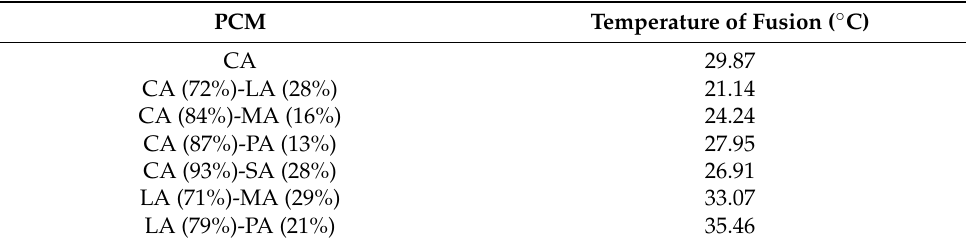
Table 6. Fatty acids of interest for the targeted application, CA: capric acid, LA: lauric acid, MA: myristic acid, PA: palmitic acid, SA: stearic acid